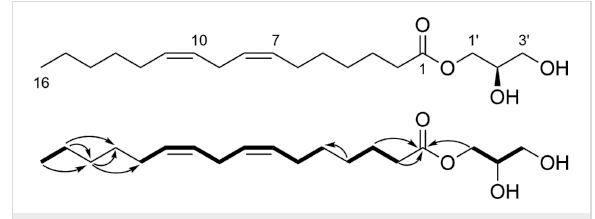
Figure 1: Structure of nostochopcerol ( 1 ) and selected COSY (bold lines) and HMBC (arrows)